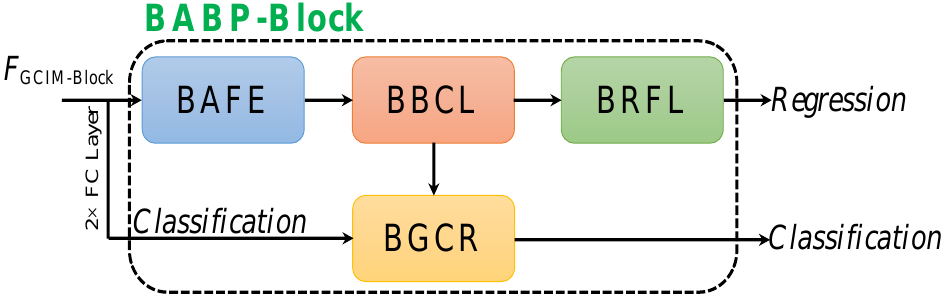
Figure 11. Workflow of the boundary-aware box prediction block (BABP-Block). Here, BAFF denotes the boundary-aware feature extraction, BBCL denotes the boundary bucketing coarse localization, BRFL denotes the boundary regression refined localization and BGCR denotes the boundary-guided classification rescoring.